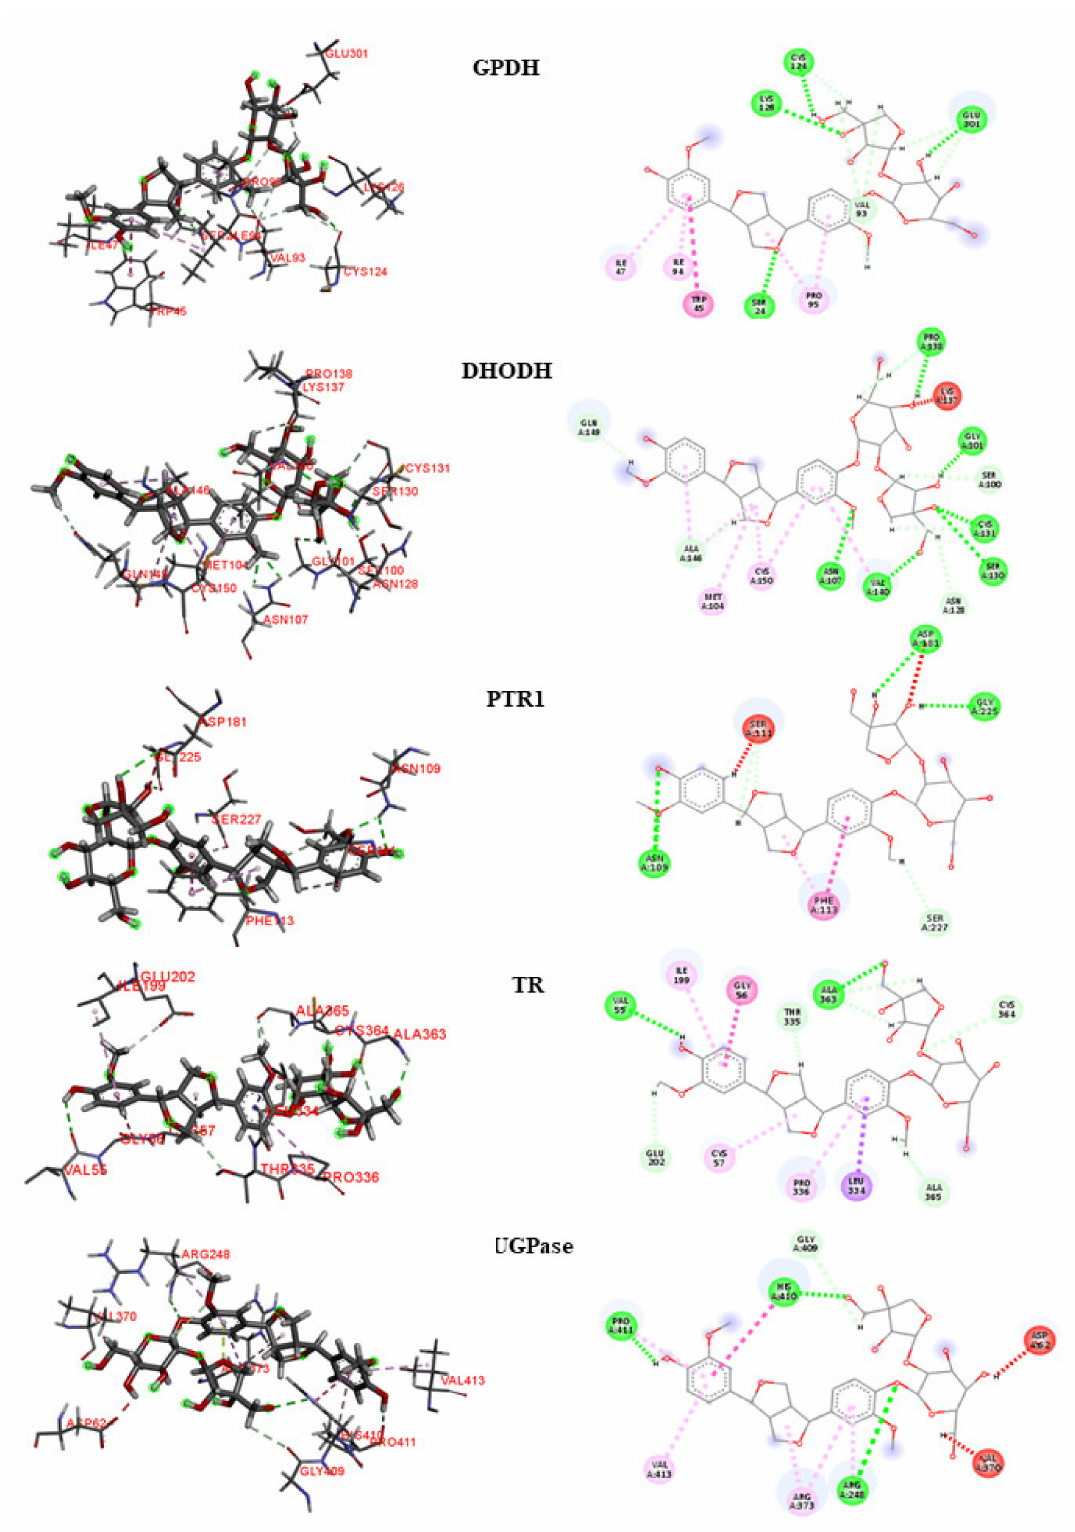
Figure 5. 3Dand2Dinteractionsbetweenlignan160andthefiveexaminedenzymes[Glycerol-3-phosphate Dehydrogenase (GPDH), Dihydroorotate dehydrogenase (DHODH), Pteridine reductase 1 (PTR1), Trypanothione reductase (TR), and UDP—glucose pyrophosphorylase (UGPase)] in L. major . Hydrogen bonds are highlighted in green; hydrophobic interactions are highlighted in pink, and electrostatic interactions are highlighted in